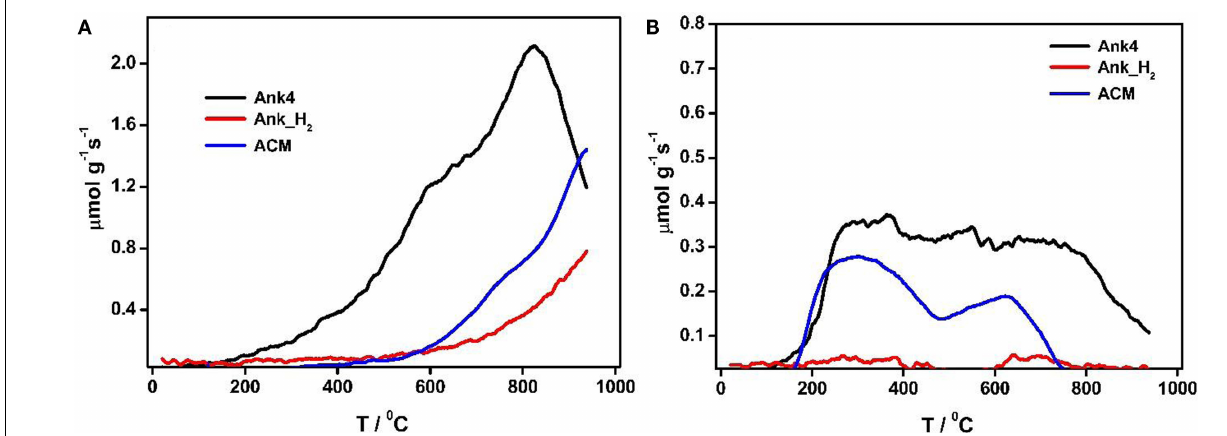
FIGURE 3 | (A) CO and (B) CO 2 TPD evolution profiles obtained from Ank4, Ank_H 2 , and ACM.